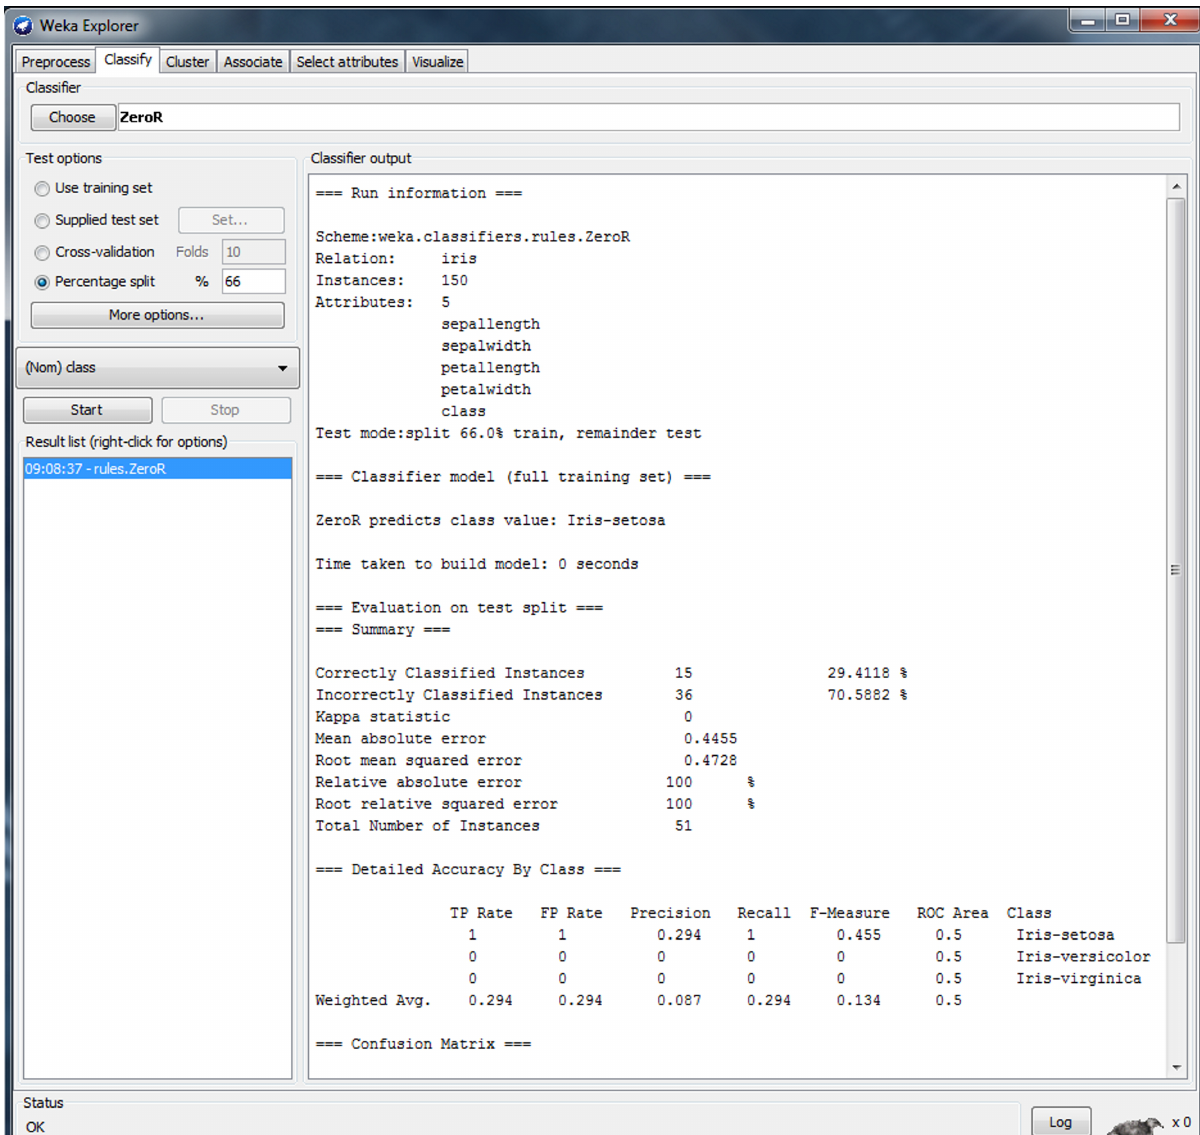
Figure 1. Weka Explorer user interface showing settings